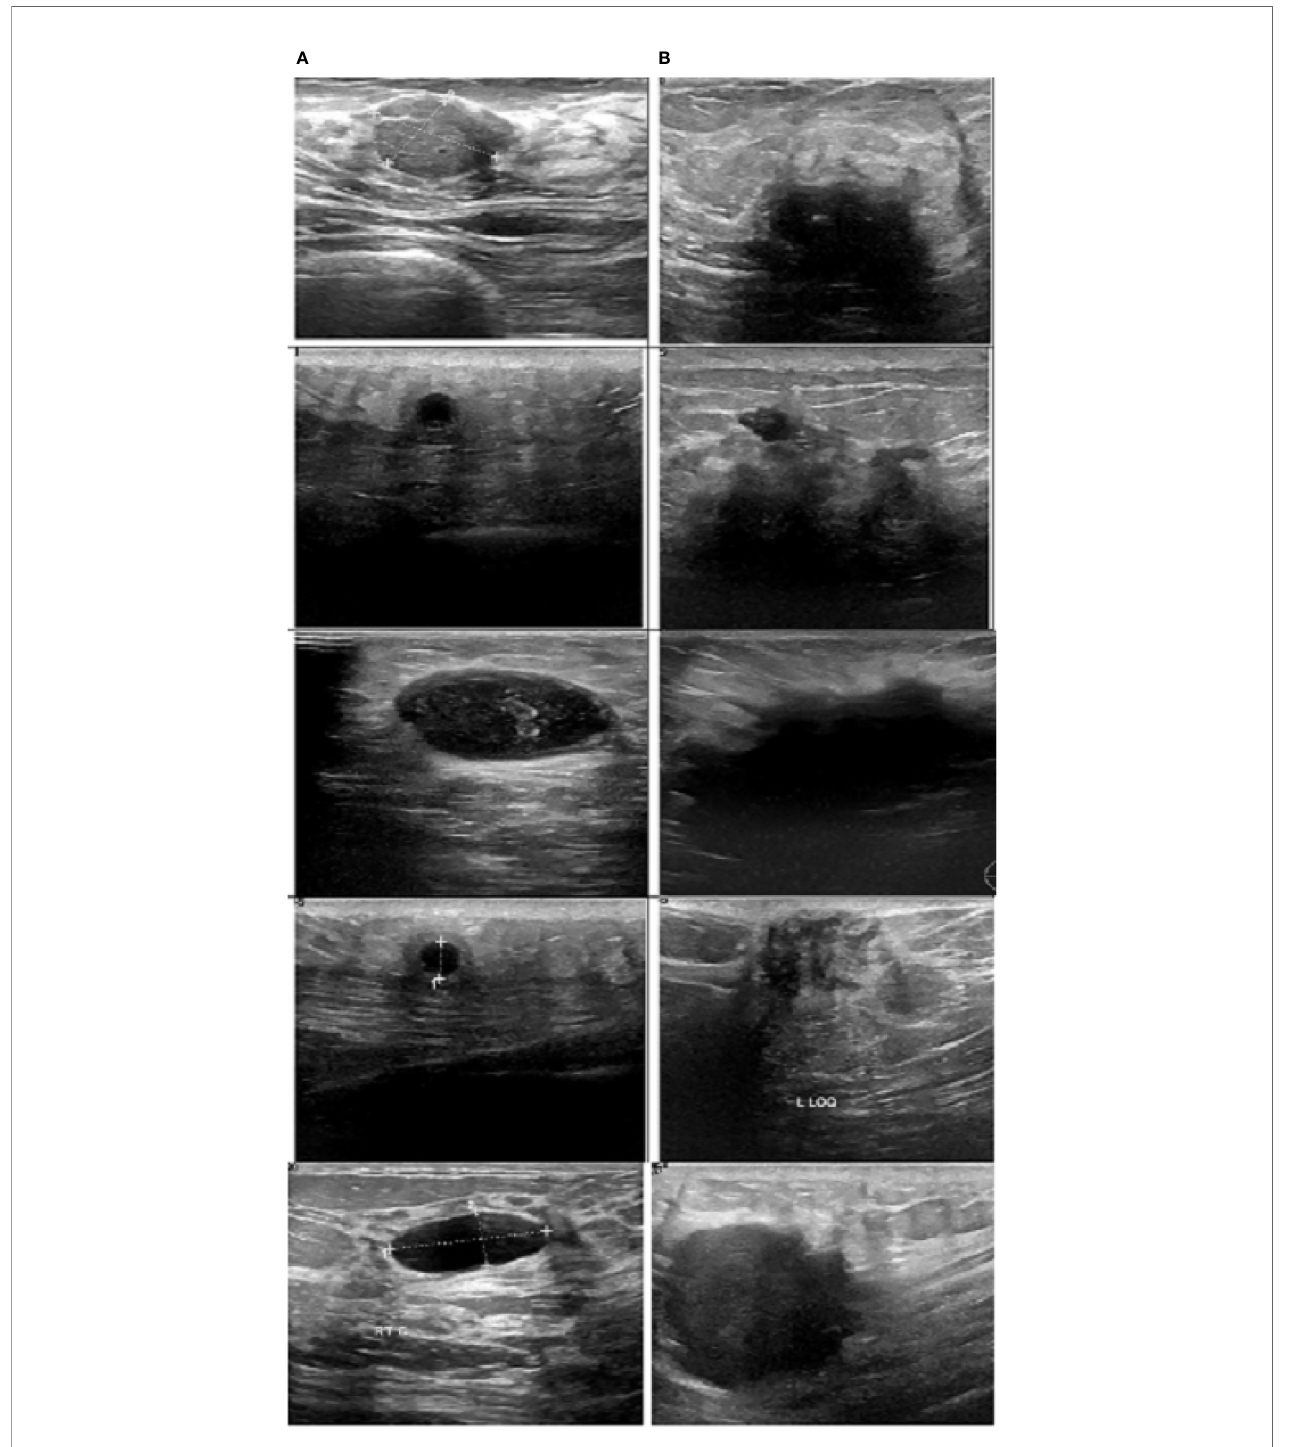
FIGURE 8 | Sample images. (A) Benign and (B) malignant